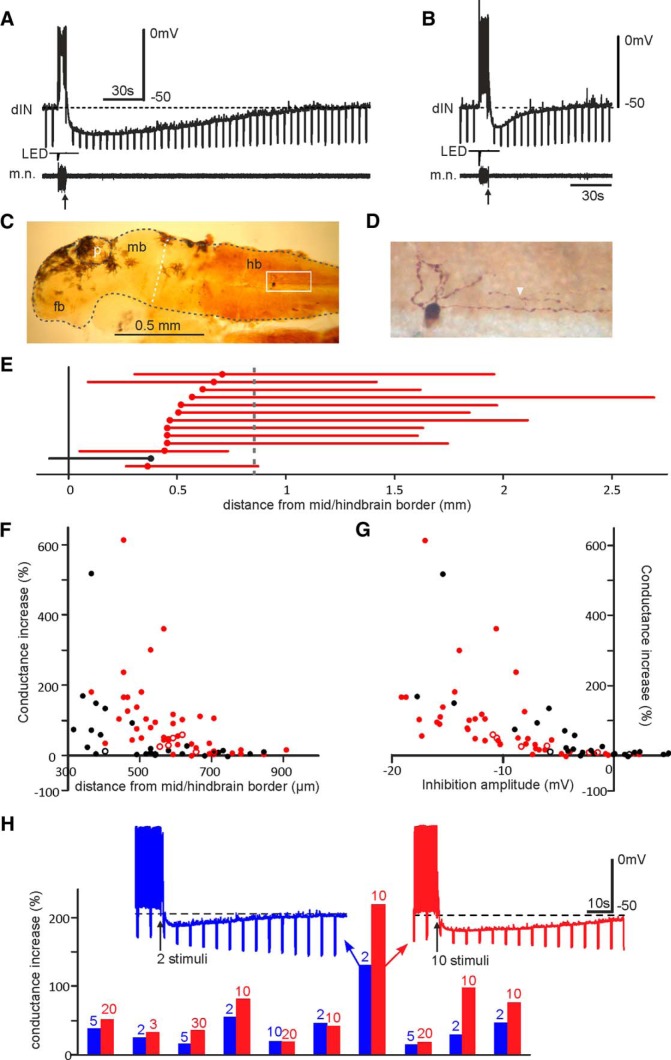
Properties of KO inhibition and their relation with the longitudinal location of neurons. A, KO inhibition in a dIN 468 µm from mid/hindbrain border following electrical skin stimulation (five pulses at 30 Hz, arrow). B, KO inhibition after 10 electrical skin stimuli (25 Hz, arrow) in a dIN 670 µm from mid/hindbrain border. Dashed lines indicate RMP in A, B. C, A dIN filled with neurobiotin in the hindbrain (hb, lateral view). Fb, forebrain; mb, midbrain; p, pineal eye. Black dashed lines outline the central nervous system. White dashed line marks the border between mb and hb (0 in E). D, Photo of the cell in C (white rectangle). Arrow head marks a short ascending axon. E, The distribution of somata (circles) and axons (lines) of 13 neurons with >100% peak conductance increases during KO. Dashed vertical line marks the position of obex. F, Longitudinal location of neurons plotted against their peak conductance increases during KO (48 dINs, 25 non-dINs, p < 0.001, two-tailed Spearman rank correlation coefficient 0.58). G, KO inhibition amplitudes plotted against conductance increases (p < 0.0001, correlation coefficient 0.834). In E–G, red symbols represent dINs; black symbols represent non-dINs. Hollow symbols are from tap experiments and solid ones from electrical skin stimulation. H, Increasing the number of electrical skin stimuli (numerals above bars) while maintaining the stimulation strengths and frequencies induces larger rises in the membrane conductance in 10 dINs. The recordings from one dIN are shown in insets.